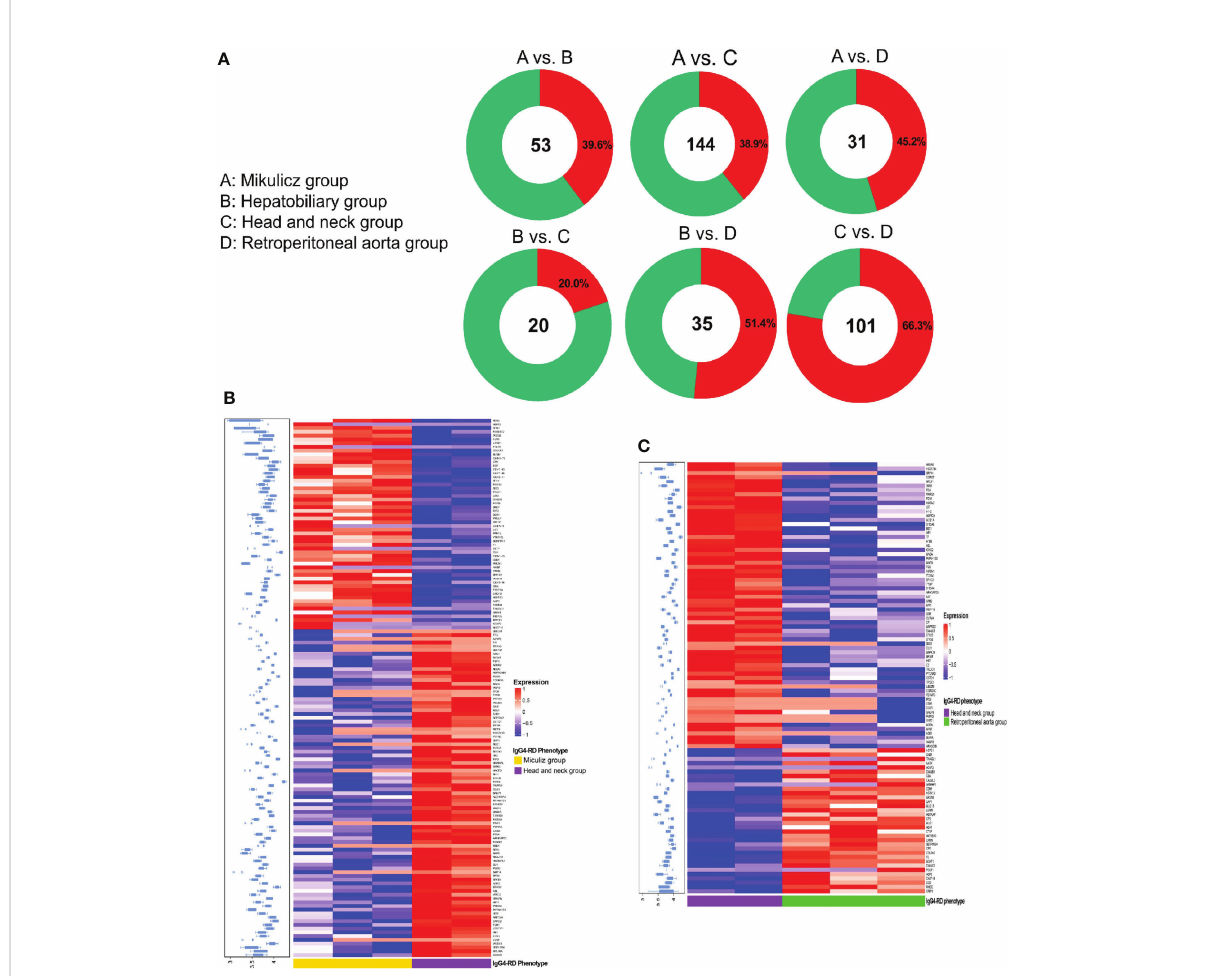
FIGURE 2 Summary of DEPs among IgG4-RD patients of distinctive phenotypes in saliva. (A) The number and ratio for up/down-expressed DEPs in comparisons of A vs. B, A vs. C, A vs. D, B vs. C, B vs. D and C vs. D in IgG4-RD in saliva. Note: A: Mikulicz group; B: Hepatobiliary group; C: Head and neck group; and D: Retroperitoneal aorta group. Red and green circle represents up and down expressed DEPs, respectively. (B) The expression heatmap of DEPs in IgG4-RD of Mikulicz group and Head and neck group. (C) The expression heatmap of DEPs in IgG4-RD of Head and neck group and Retroperitoneal aorta